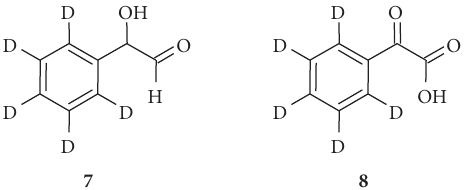
F 2: Byproducts deriving from intermolecular hydride migra- tion in step 2 in Scheme